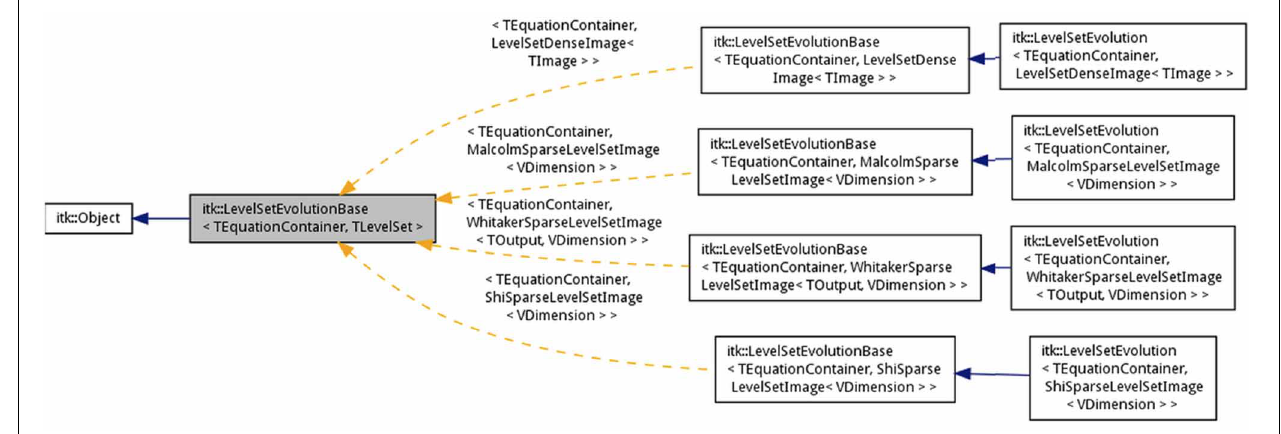
FIGURE 5 | Inheritance mechanism for level-set evolution